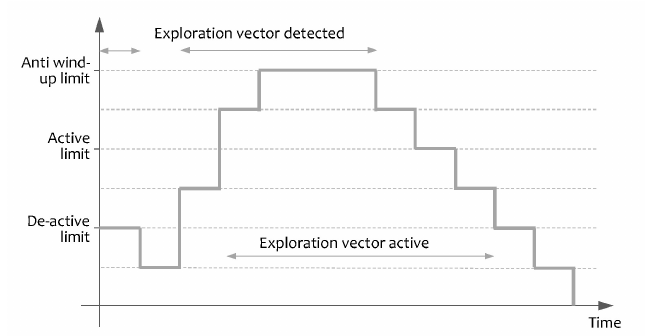
Figure 3. Hysteresis algorithm applied to the exploration vectors.